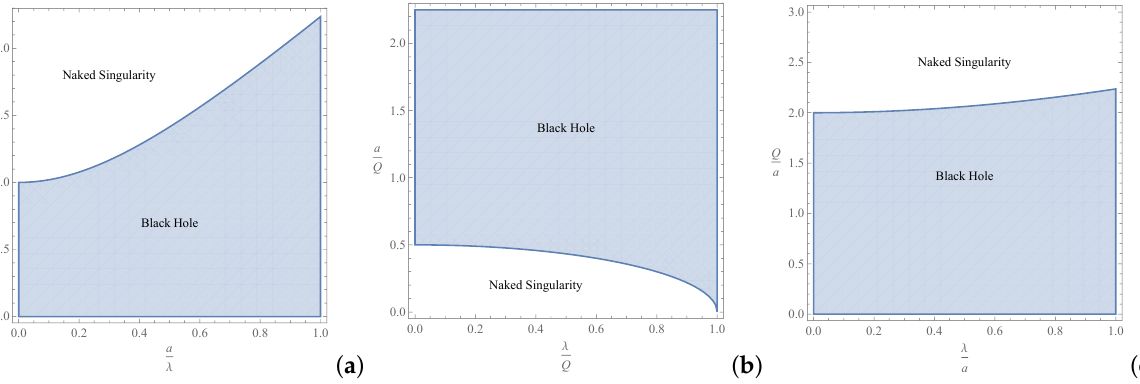
Figure 1. The mutual sensitivity of the possibility of horizon formation to the pairs ( a ) ( Q , a ) , ( b ) ( a , λ ) , and ( c ) ( Q , λ ) . In the diagrams, the border between the regions of black hole and naked singularity indicates the extremal black hole limit.